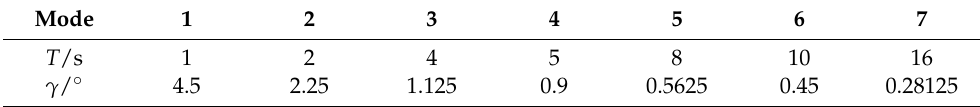
Table 1. Seven scanning modes of our